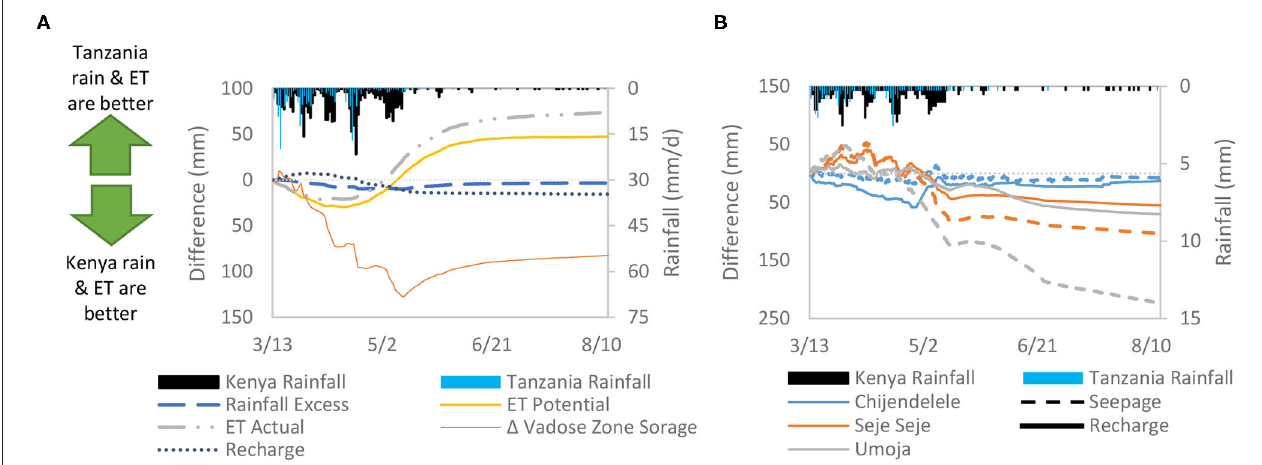
FIGURE 8 | (A) Comparative trends in aggregate overland flow quantities for the Chididimo watershed after changing the rainfall variability and ET. (B) Comparative trends in groundwater flow parameters for each of the three sand dams after changing the rainfall variability and ET. For both (A,B) , a quantity above the y = 0 line indicates that S1 (Tanzania climate) produced values more beneficial to water storage in sand dams than S3 (Kenya climate). The converse also applies with quantities below the y = 0 line indicating S3 is more